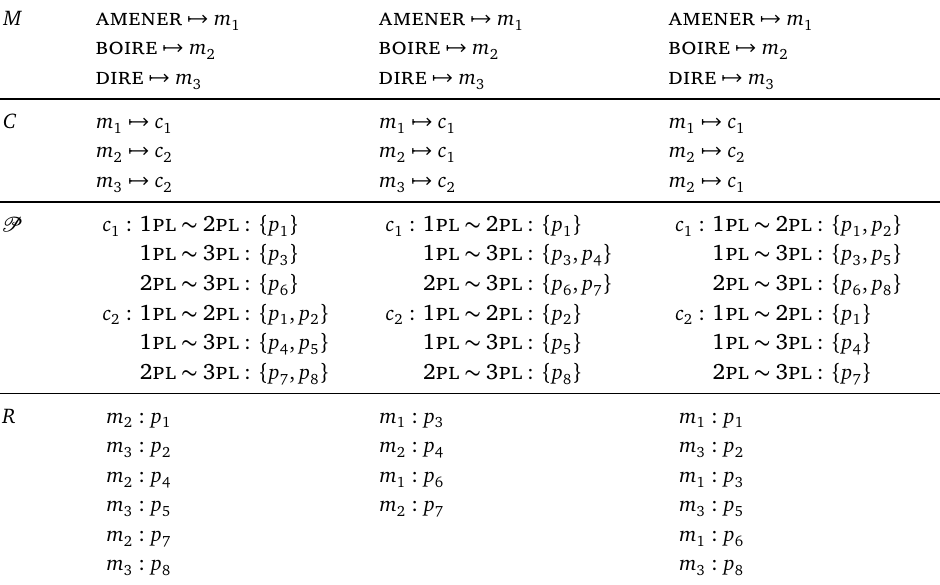
Table 9: Detailed description of three classifications of the paradigms from Table 8 in microclasses and